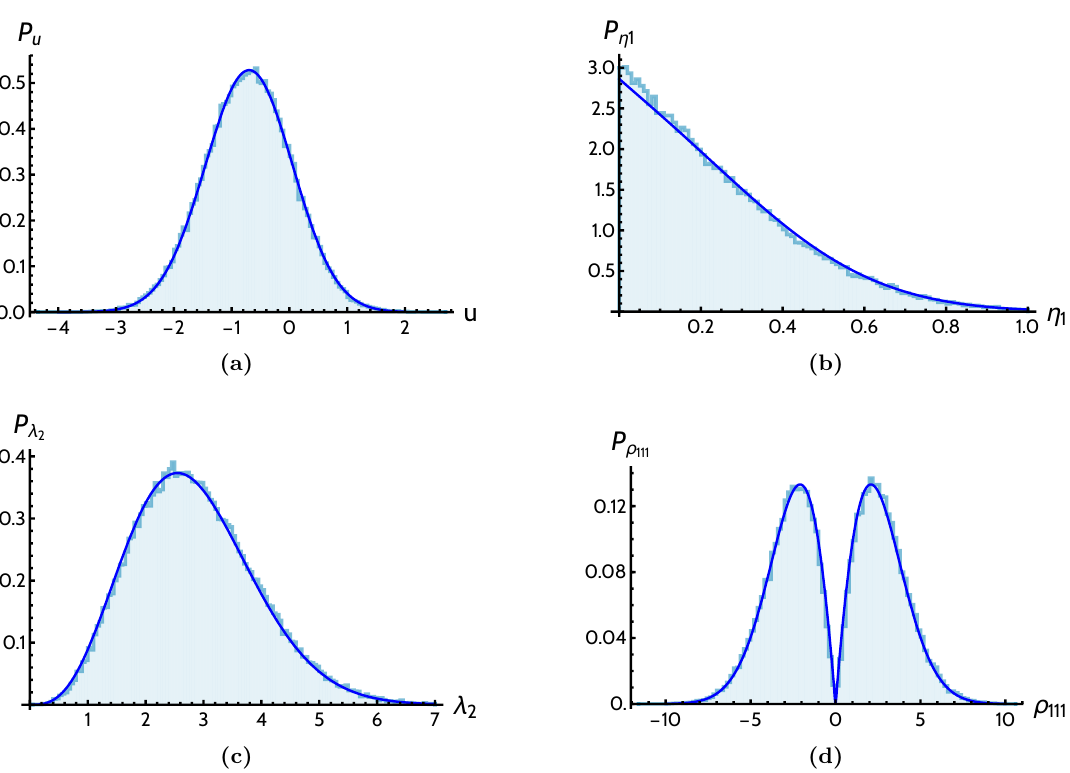
Figure 14. Normalized histograms of (a) height (b) (cid:17) 1 (c) (cid:21) 2 (d) (cid:26) 111 for in(cid:13)ection points and their expected PDFs (B.7){(B.10), constrained by the condition (cid:21) 2 =(cid:17) 1 >